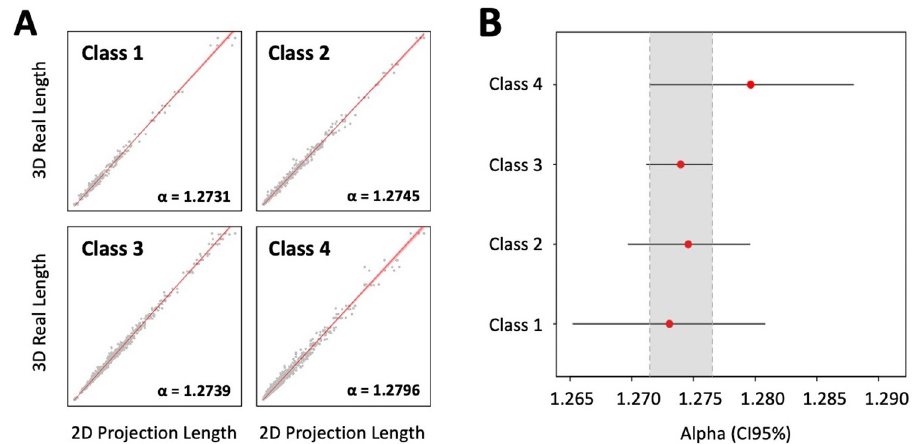
Fig 4. Axon length correlations for projection-based stereology. A . Correlation between 3D real length and 2D projection length, by axonal class. Red lines represent the mean estimated 3D real length (ordinary least squares), and light red shaded areas correspond to 95% confidence intervals (CI95%). Gray dots depict full samples comprising all planes measurements (XY, XZ and YZ, note the organization of the data in triplets). Global adjusted R-squared = 0.99. B . Estimated slopes (red dots) and CI95% (horizontal black bars) values for correlations in A. Slopes can be interpreted as coefficients (alpha) that multiply 2D projection values to obtain predictions of 3D real lengths. Note that all axon classes share a common set of potential alphas at a 95% confidence level (gray shaded area).